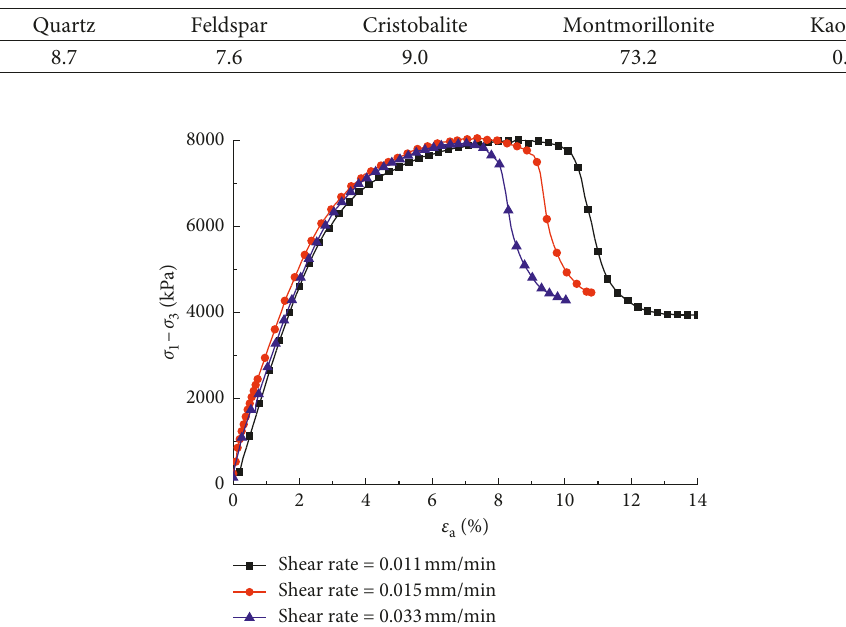
Table 4: Mineral compositions of GMZ001 bentonite